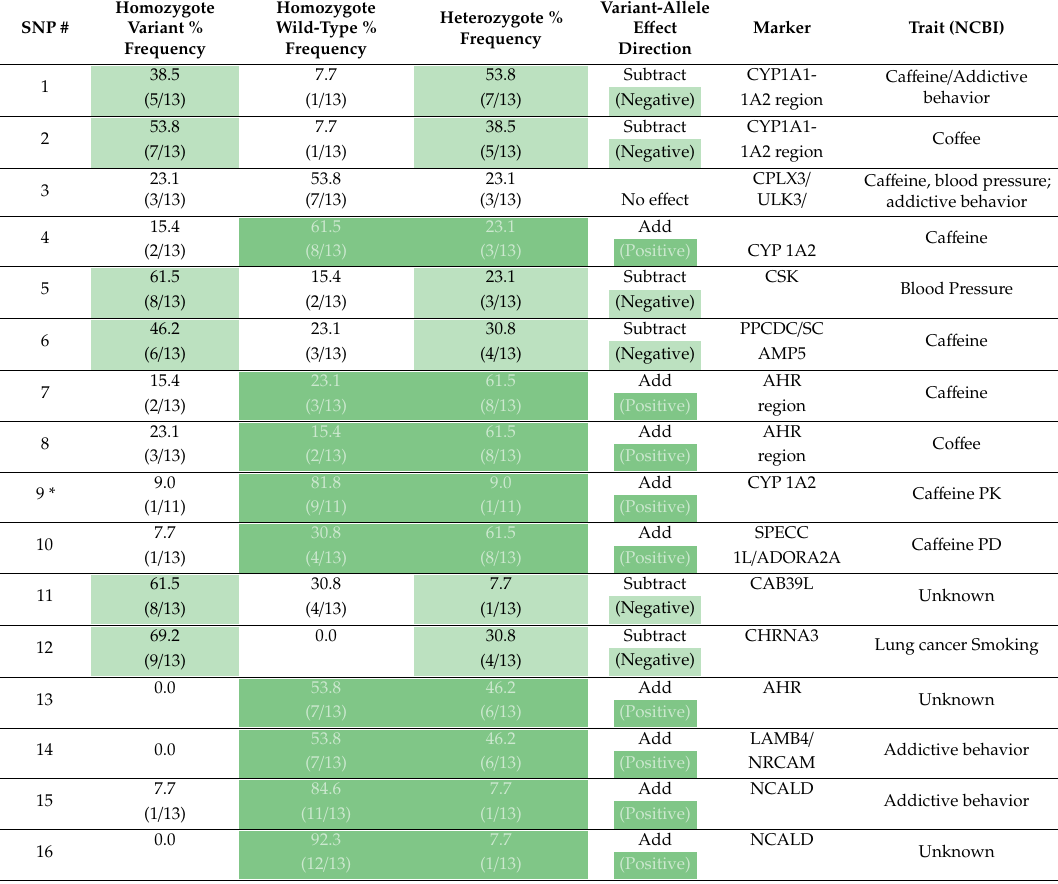
Table 2. Potential Variant Allele direction e ff ect for each of the 16 SNPs